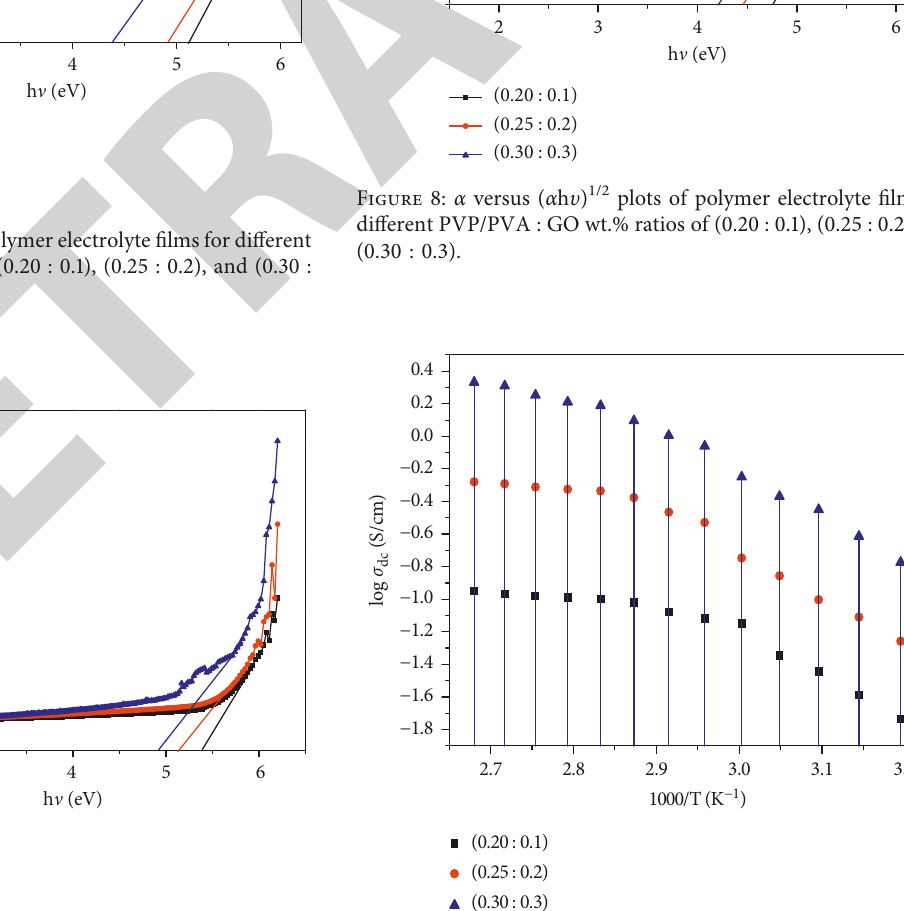
Figure 9: DC-conductivity plots of polymer electrolyte films for different PVP/PVA : GO wt.% ratios of (0.20 : 0.1), (0.25 : 0.2), and (0.30 :